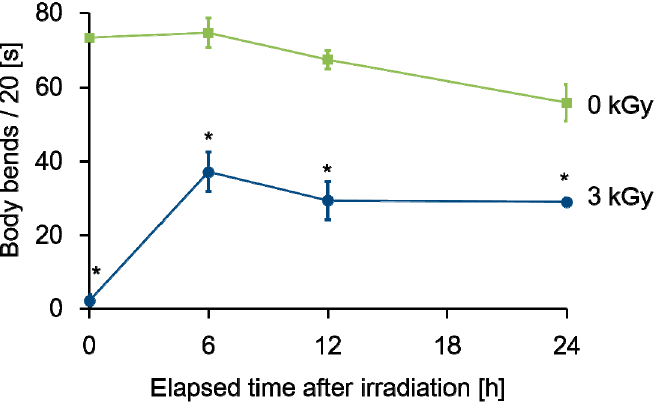
Figure 6. Time course of swimming ability of C. elegans after whole-body γ -ray irradiation. Head